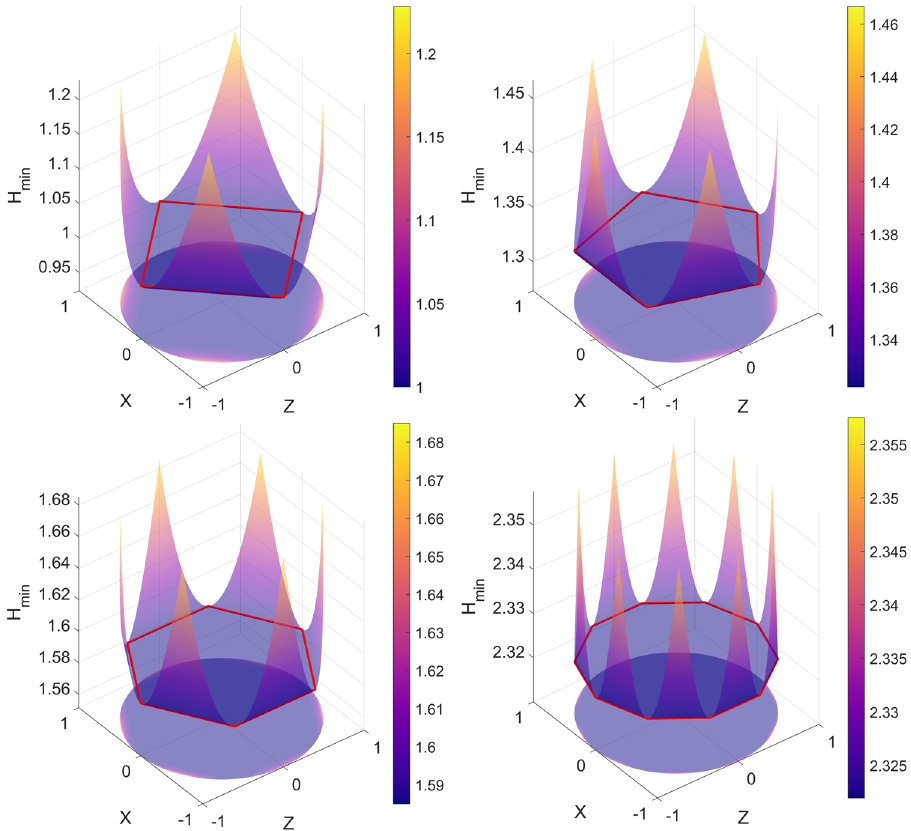
Fig. 2 Min-entropy 3D plot for different POVM outcomes. 3D plot of H min ( X ∣ E ) in function of the projection of ^ ρ A in the ZX plane. The POVM considered have 4, 5, 6, 10 equispaced elements in the ZX plane. In the region inside the red lines the lower-bound of the min-entropy is reached.